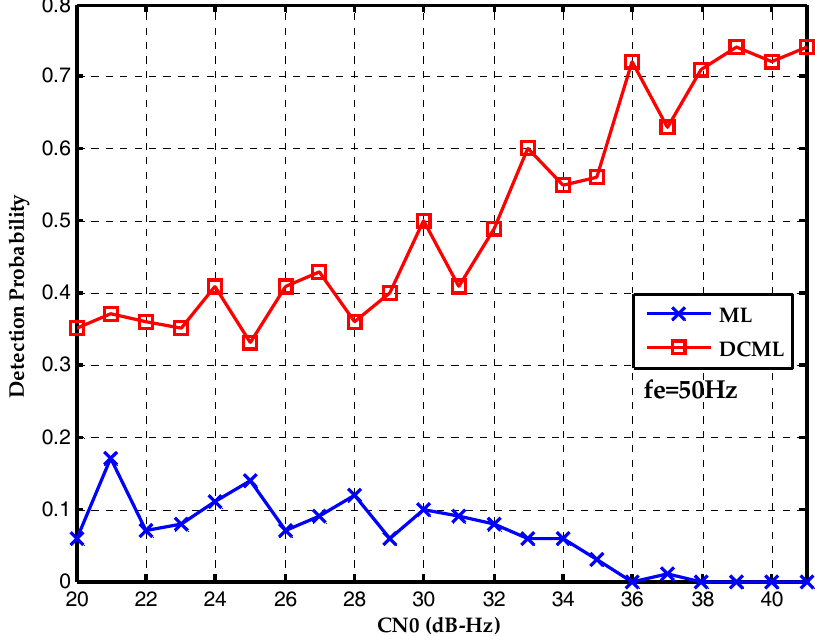
Figure 12. Detection probabilities of ML and DCML bit synchronization algorithms under the CN0s of 20~40 dB-Hz with a frequency deviation of 25 Hz.